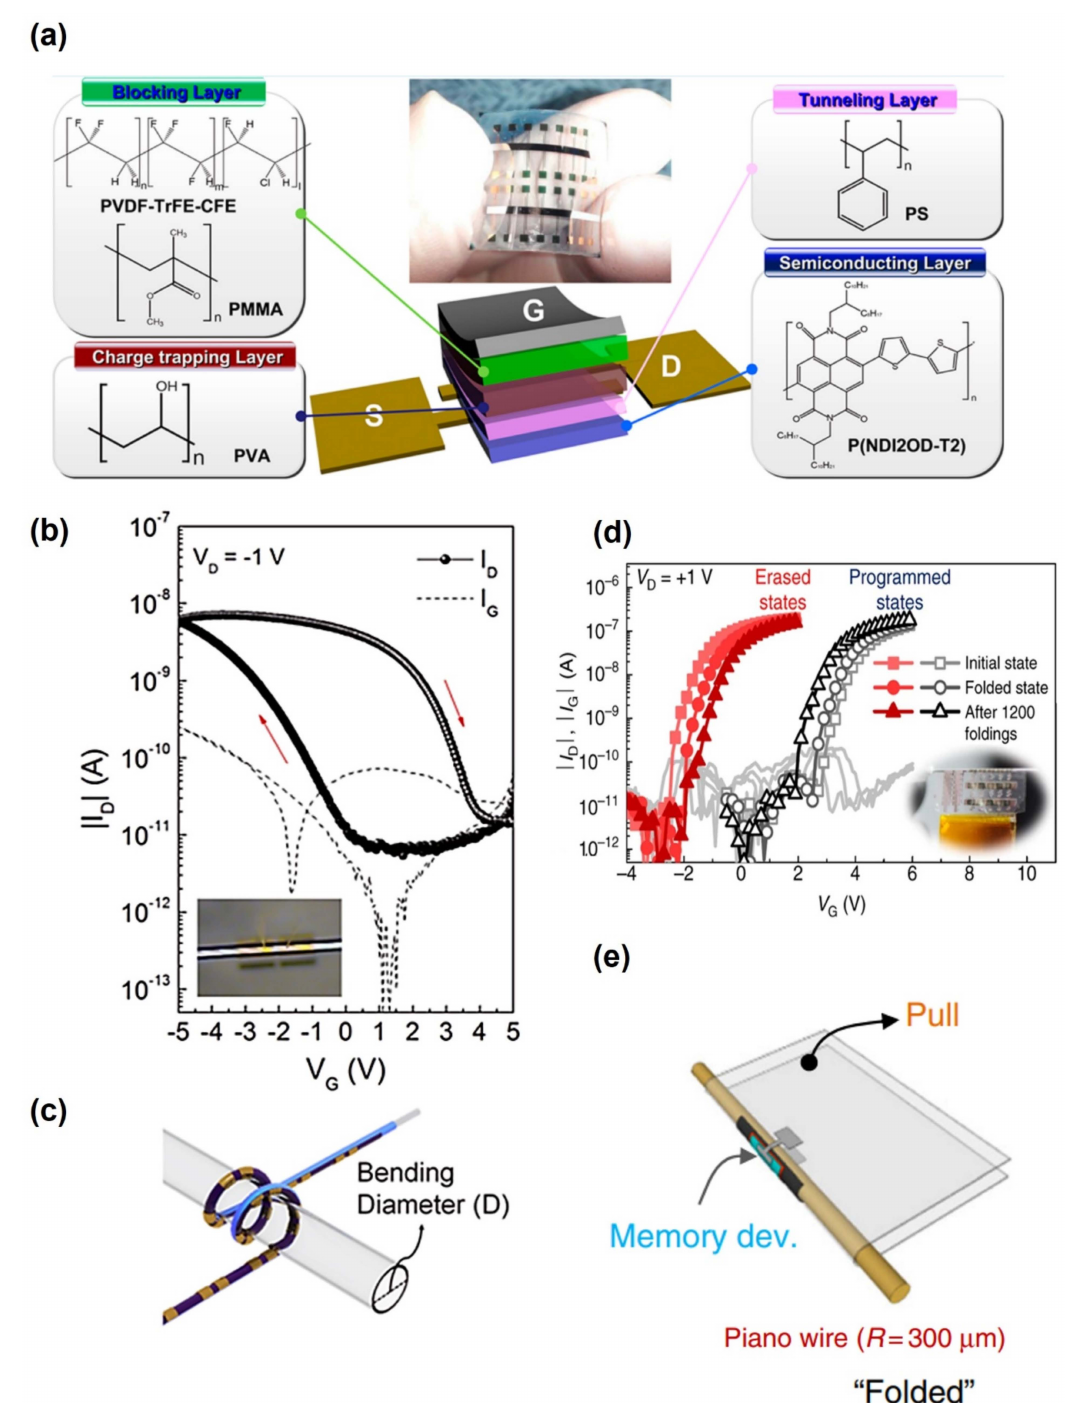
Figure 9. ( a ) Schematic diagram of the top-gate organic FET non-volatile memory with all polymers semiconducting, tunneling, charge trapping, and blocking layers. The chemical structure of each layer of polymers material (adapted from [128] with permission from the American Chemical Society). ( b , c ) Illustration of the fibriform memory coiled on a capillary tube with a diameter of 1.1 mm during measurement and transfer curve (adapted from [130] with permission from the American Chemical Society) . ( d , e ) Memory characteristics after 1200 folding cycles with a folding radius of 300 µ m, which is comparable to the radius of the piano wire (adapted from [124] with permission from